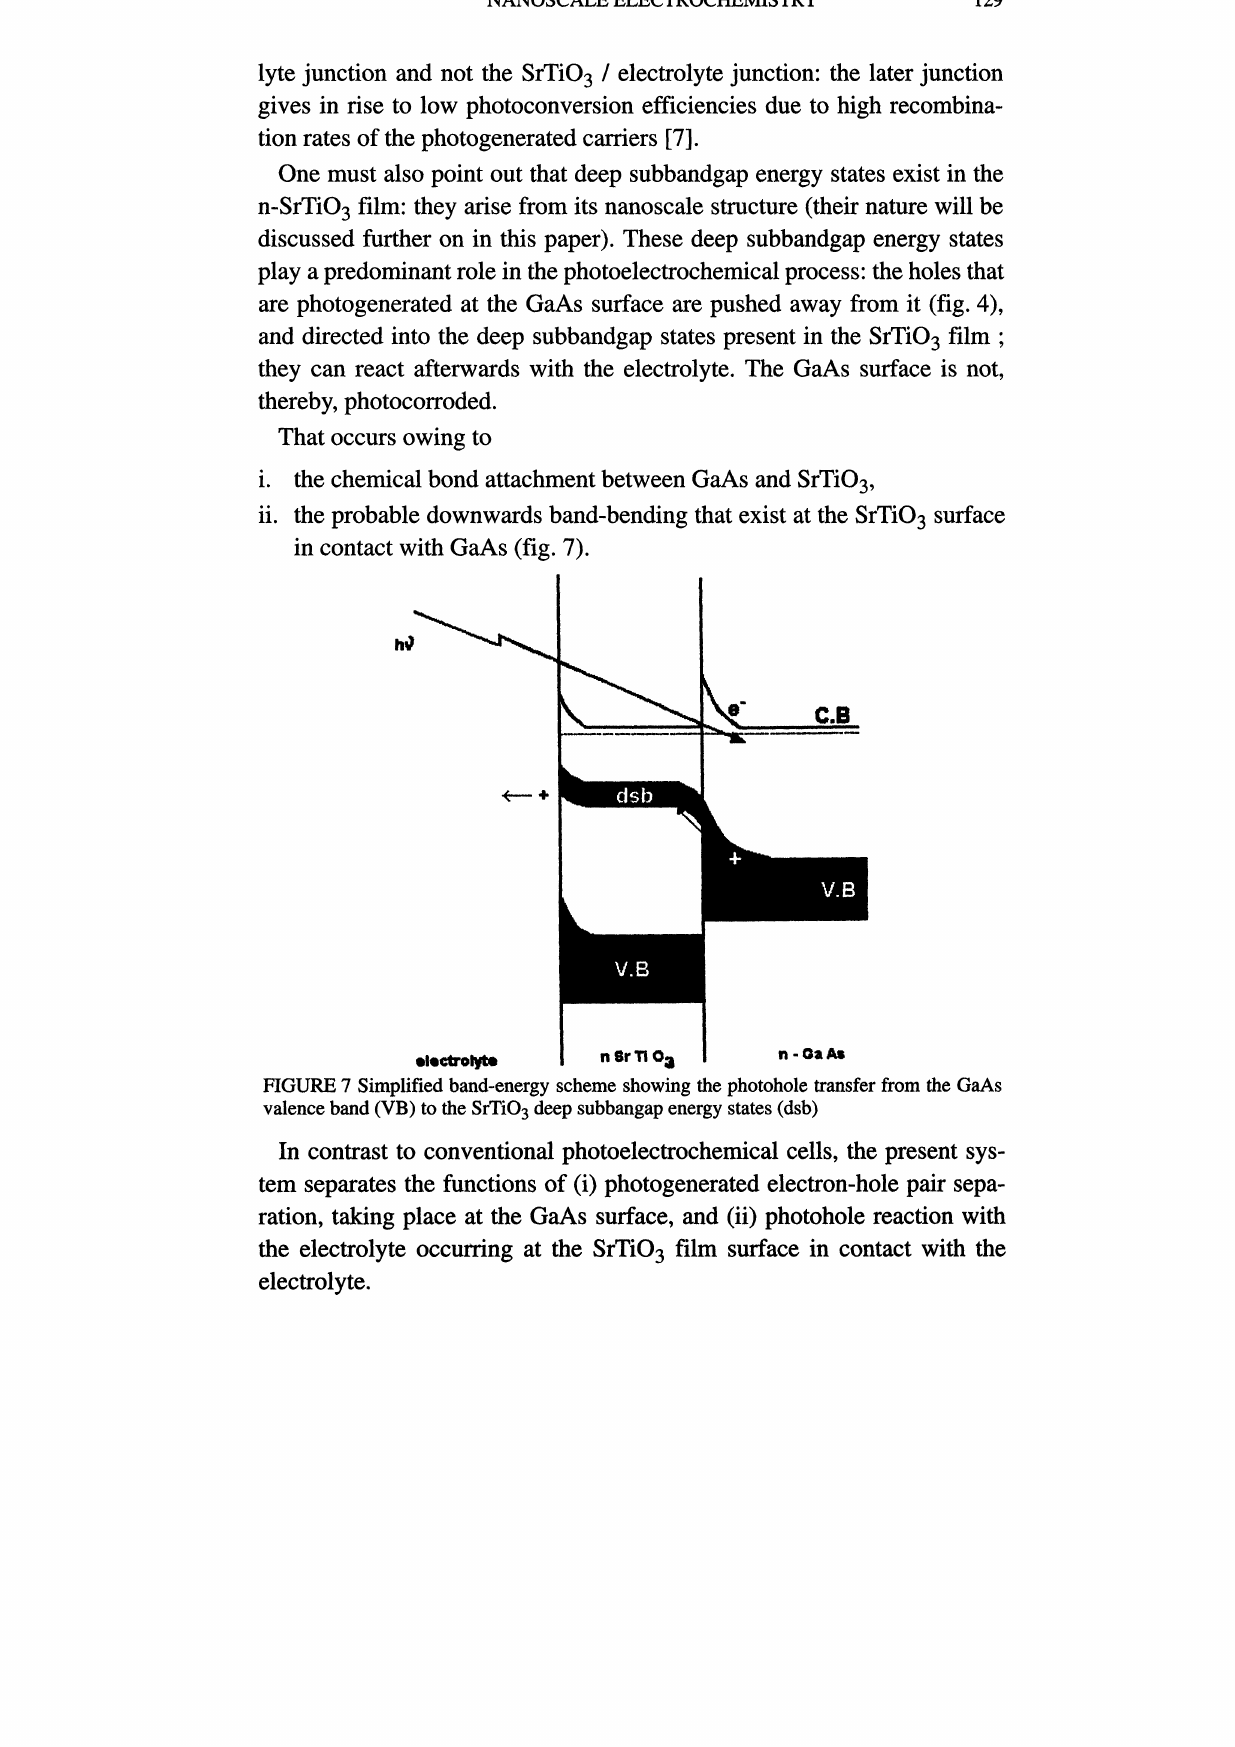
FIGURE 7 Simplified band-energy scheme showing the photohole transfer from the GaAs valence band (VB) to the SrTiO deep subbangap energy states